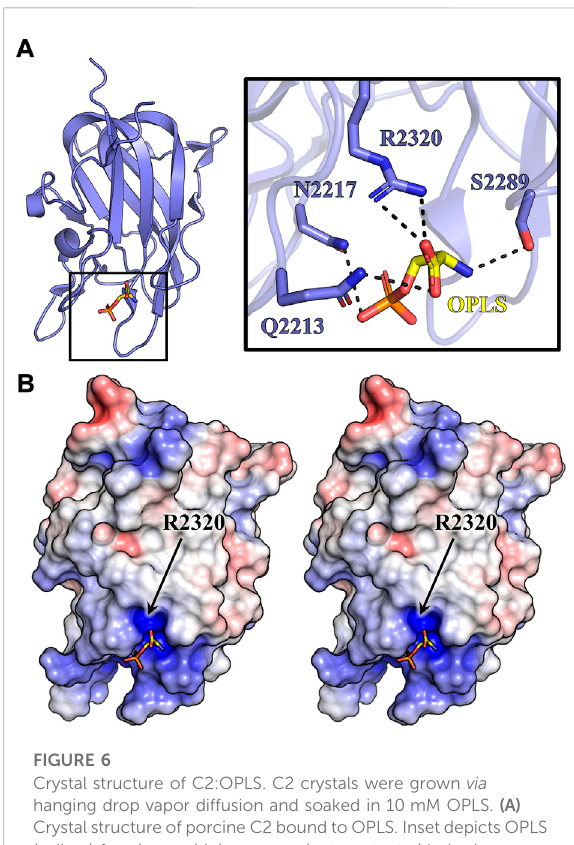
FIGURE 6 Crystal structure of C2:OPLS. C2 crystals were grown via hanging drop vapor diffusion and soaked in 10 mM OPLS. (A) Crystalstructure ofporcine C2 bound to OPLS. Insetdepicts OPLS (yellow) forming multiple noncovalent contacts (dashed lines) with C2 residues (slate). (B) Stereo view of the electrostatic surface map of the C2:OPLS crystal structure (red: negative charge, blue: positive charge, white: neutral). OPLS (sticks) is situated within the most basic cleft on the C2